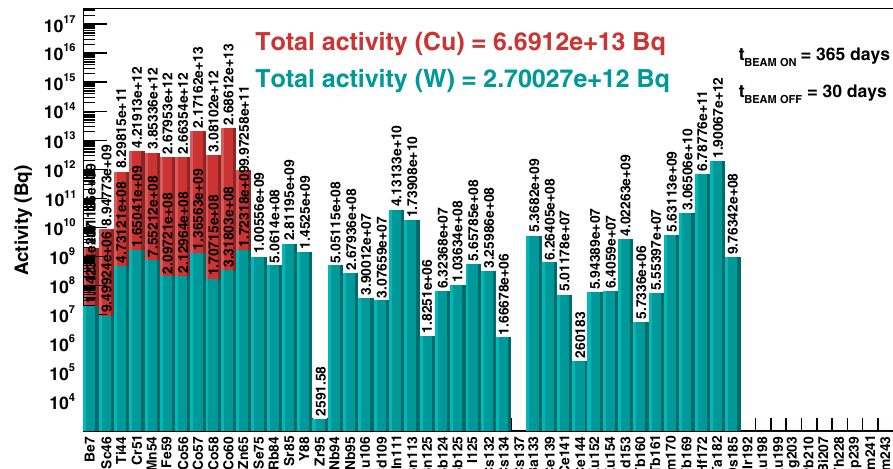
FIG. 11. Total induced activity inside the HEBT-S3 collimator. Isotopes produced in the copper yield of the collimator are shown in red, isotopes produced in the tungsten coating of the collimator are shown in green.